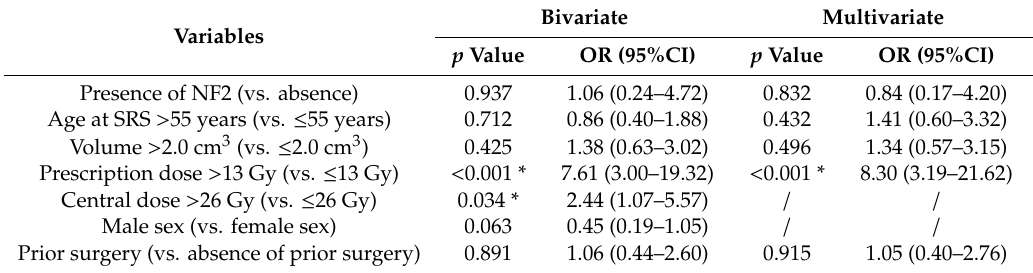
Table 4. Results of bi- and multivariate analyses of cranial nerve injuries as radiation-related adverse events before matching. * Values of p < 0.05 are considered statistically significant. OR = odds ratio; CI = confidence interval; NF2 = neurofibromatosis type 2; SRS = stereotactic radiosurgery. Gy =